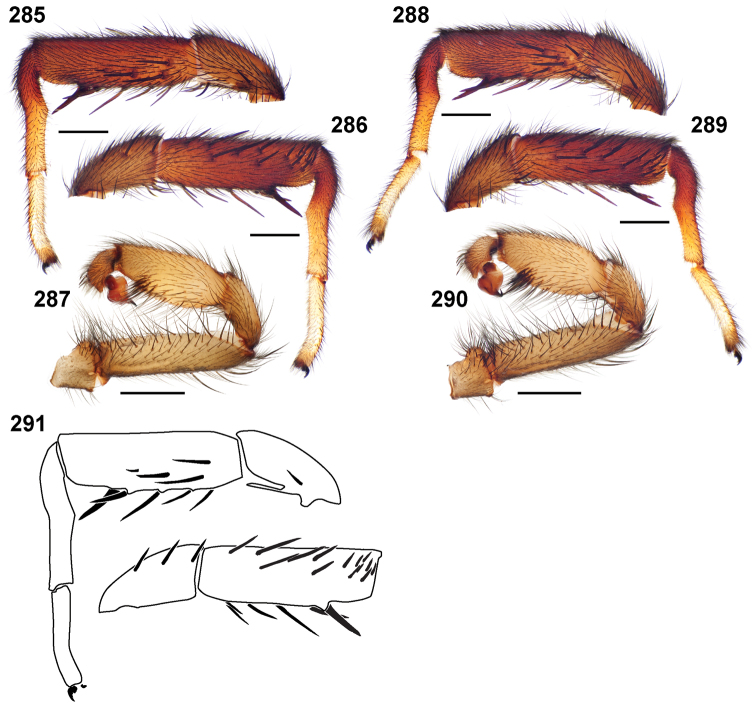
Aptostichus satleri sp. n. holotype (MY3825) and paratype (MY3826) males from Kern County; scale bars = 1.0mm. 285 retrolateral aspect, leg I [806495] 286 prolateral aspect, leg I [806499] 287 retrolateral aspect, pedipalp [806501] 288 retrolateral aspect, leg I [806503] 289 prolateral aspect, leg I [806507] 290 retrolateral aspect, pedipalp [806509] 291 line drawings of leg I spination pattern; retrolateral aspect of patella, tibia, metatarsus, tarsus; prolateral aspect of patella and tibia.